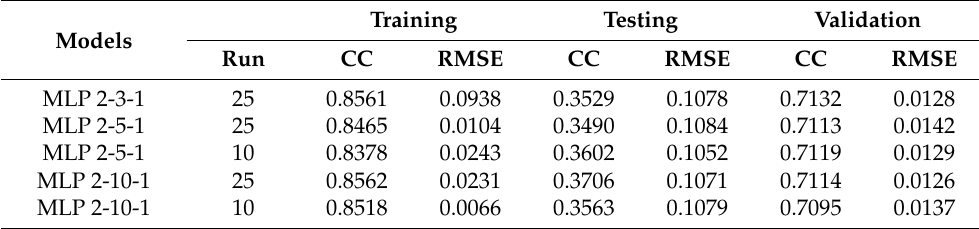
Figure 7. Scatter plot of target vs. predicted Pb using various neural networks models based upon MLP in validation stage. MLP in validation stage. Table 4. Correlation coefficients and RMSE values for different MLP topologies in all stages for Pb.